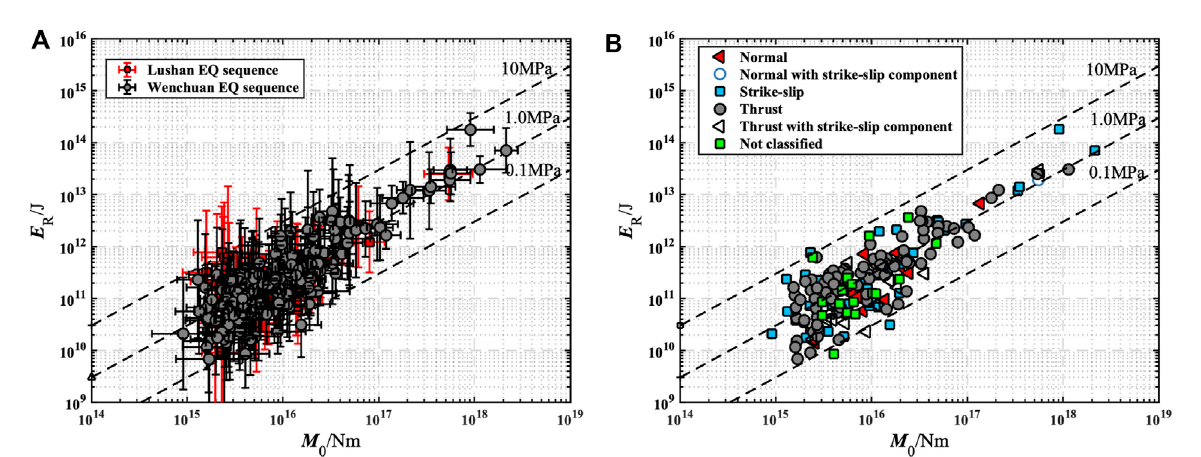
FIGURE 4 Scalingoftheradiatedseismicenergywiththeseismicmomentand ± 1standarddeviationfortheestimatedparameters(horizontalandvertical black lines, respectively) for (A) : the Lushan and Wenchuan earthquake sequences and (B) : the type of